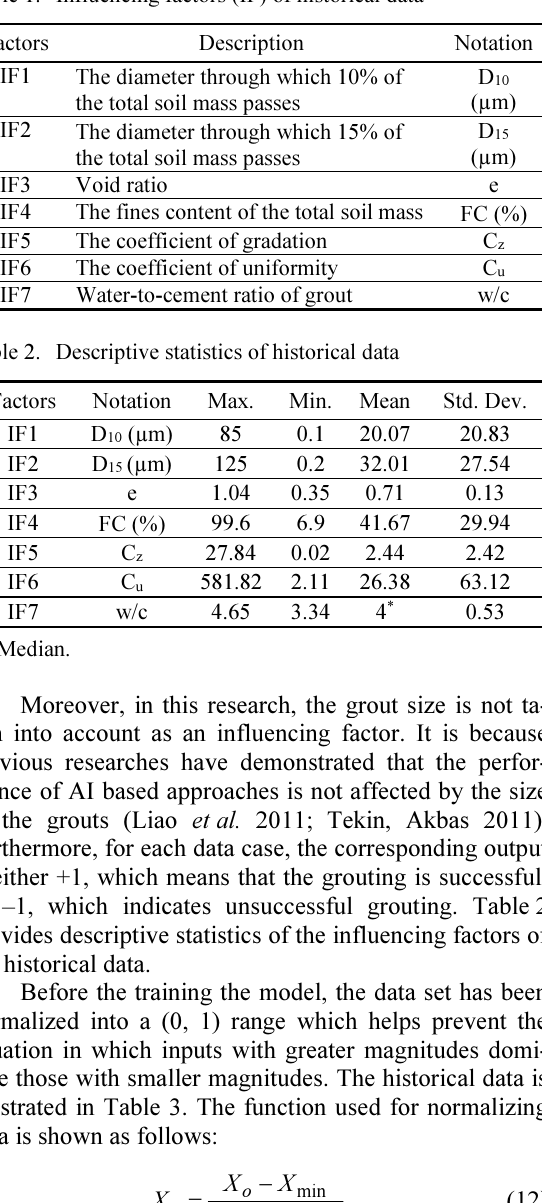
Table 1. Influencing factors (IF) of historical data